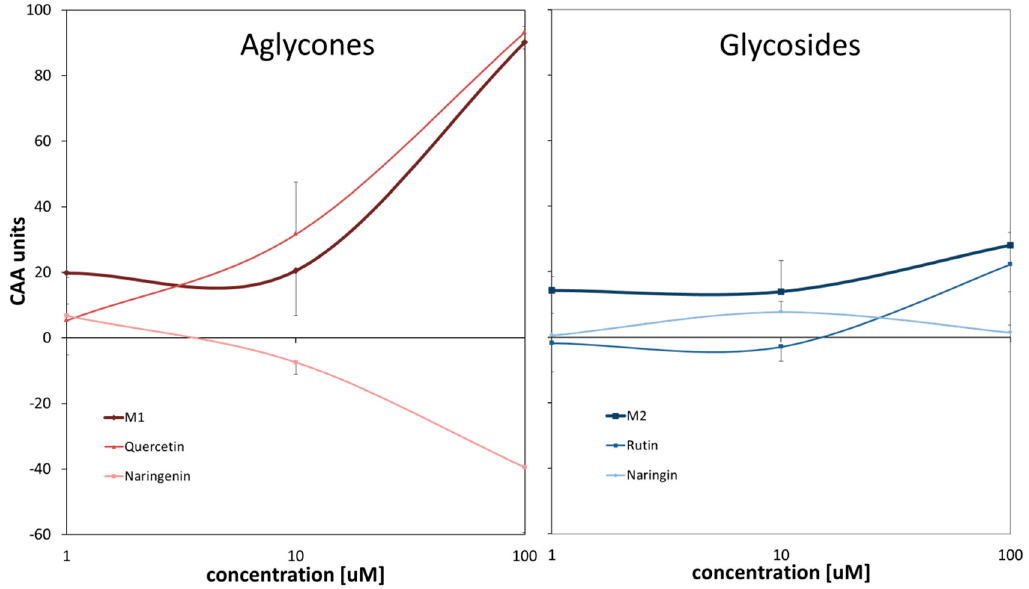
Figure 1. The relationship between cellular antioxidant activity (expressed as CAA units) and the concentration of rutin, quercetin, naringin, naringenin and their mixtures. The results are means of three independent experiments carried out in